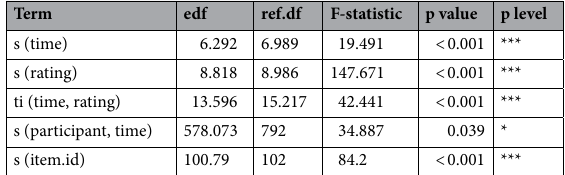
Table 3. Summary output for the basic GAMM modelling participants’ pupil sizes in response to morpho- syntactic